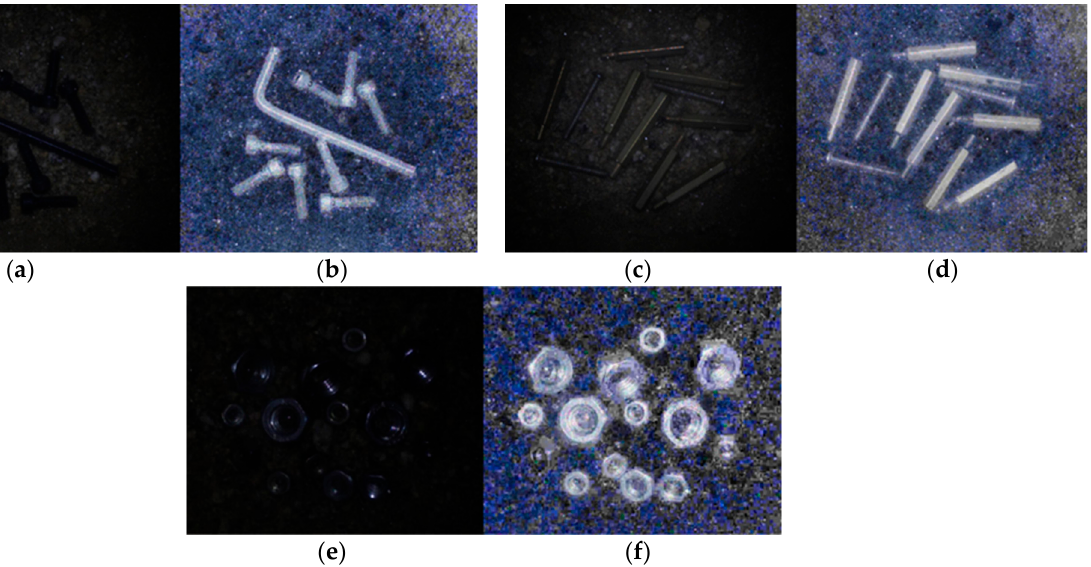
Figure 12. Image I and DOP of different targets: ( a ) image I of metal 1; ( b ) image DOP of metal 1; ( c ) image I of metal 2; ( d ) image DOP of metal 2; ( e ) image I of metal 3; ( f ) image DOP of metal 3.